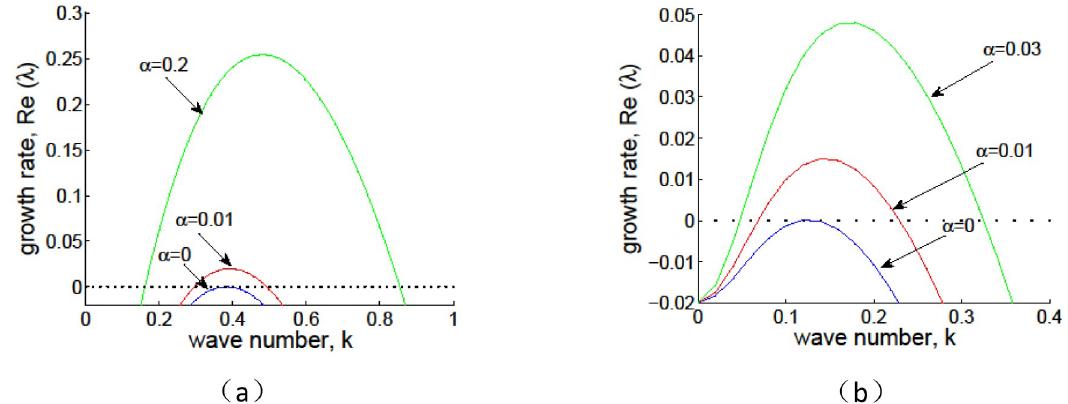
Fig 7. Effect of α on the stability of E + by the dispersion relation from Eq (9). The parameter values are (a) p = 1, δ = 0.45, v = 9, which corresponds to grass; (b) p = 0.1, δ = 0.045, v = 30, which corresponds to tree.